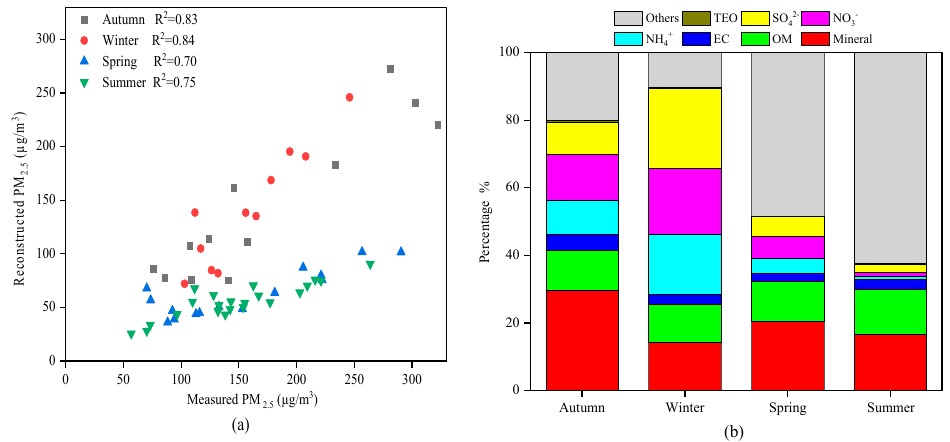
Figure 10. Chemical mass components of PM 2.5 in four seasons in Urumqi. ( a ) Comparison of the measured PM 2.5 mass concentration with the reconstructed PM 2.5 mass concentration, ( b ) proportions of all components in the PM 2.5 in the four seasons.